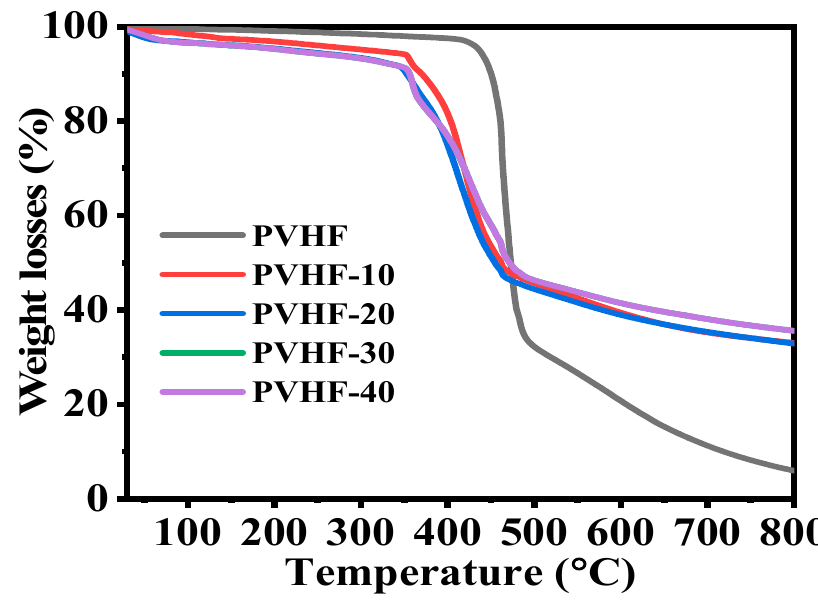
Figure 5. TGA graph of PVHF and Co@PVHF membranes. Figure 6 shows the FTIR of PVHF and Co@PVHF membranes. Both of the plots representing the polymeric membrane had common vibrational bands and phases that were validated by peaks at 749 and 837 cm − 1 [63]. In the non-crystalline phase of